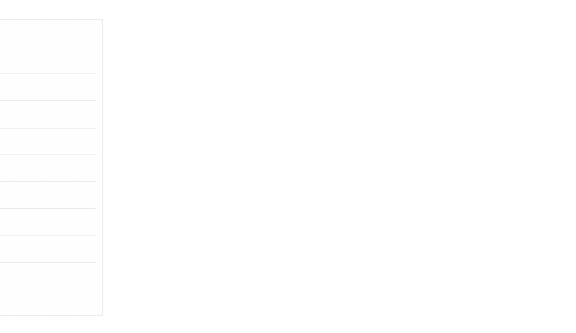
Figure 19. Error in overall 3D reconstruction for the photogrammetry procedure with Ag- isoft Metashape.